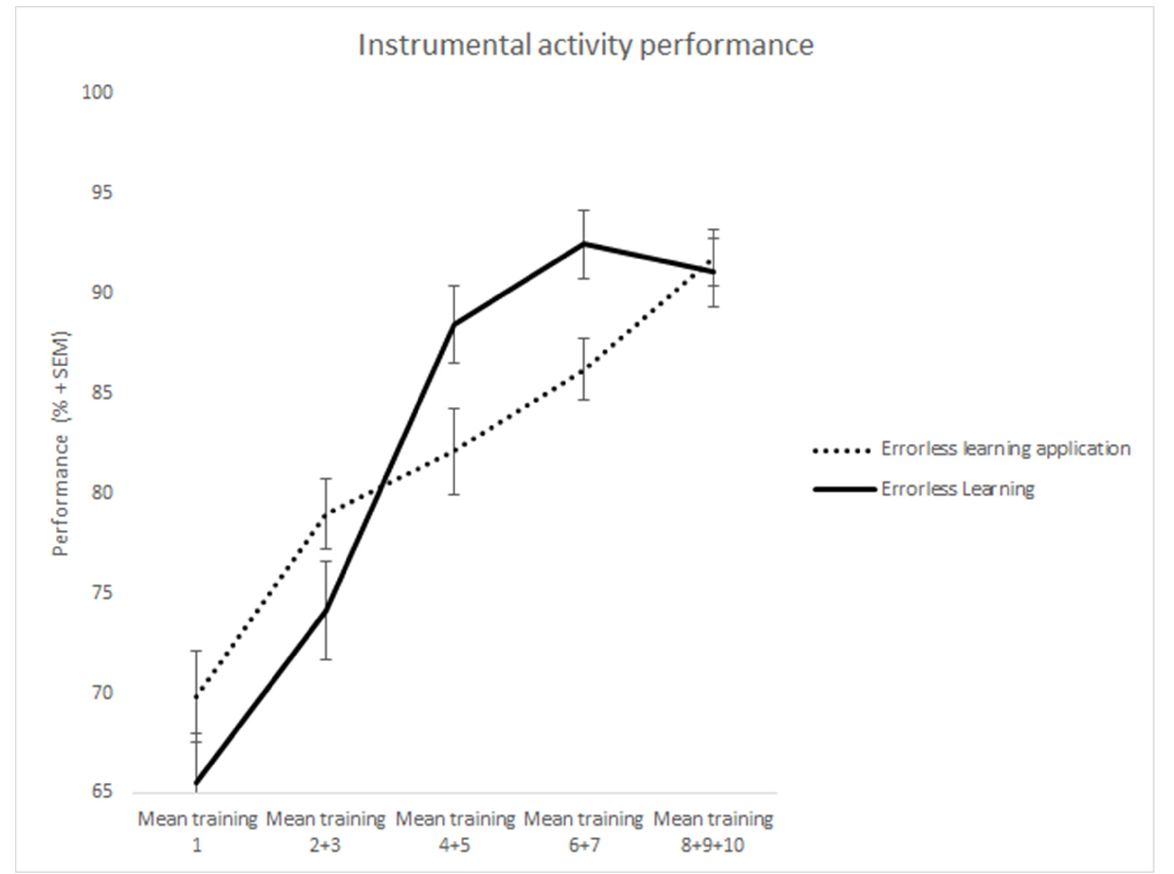
Figure 2. The mean scores within the ELA group and the EL group. Both groups performed equally well on the first learning session: ELA; M = 1.34; SD = 0.37, P&P; M = 1.37; SD = 0.23. (t(14) = 1.1, p = 0.291). There were no significant differences found.